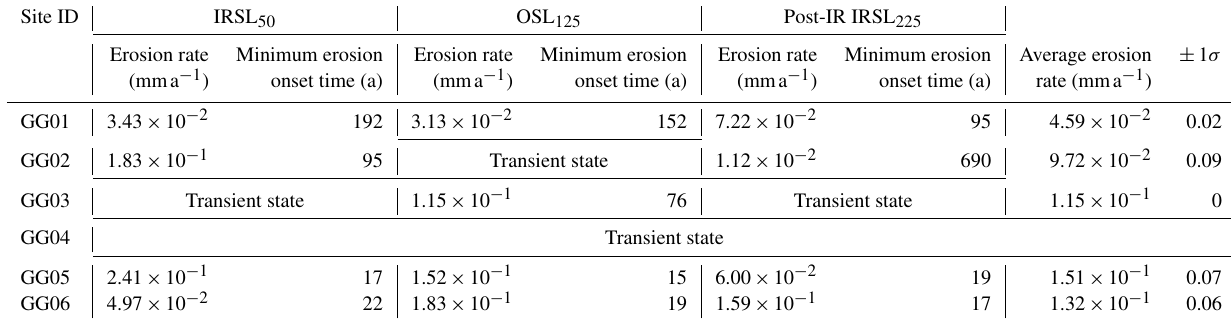
Table 4. Summary of inferred erosion histories across the three luminescence signals. Site ID IRSL 50 OSL 125 Post-IR IRSL 225 Erosion rate Minimum erosion Erosion rate Minimum erosion Erosion rate Minimum erosion Average erosion ± 1 σ (mma − 1 ) onset time (a) (mma − 1 ) onset time (a) (mma − 1 ) onset time (a) rate (mma − 1